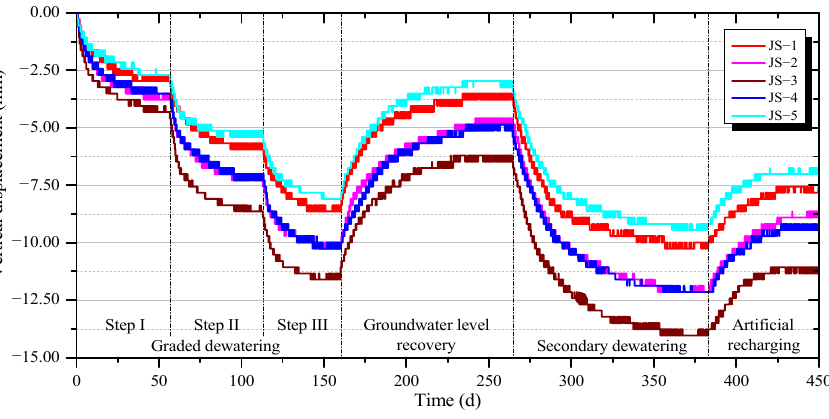
Figure 6. Vertical settlement along the tunnel.